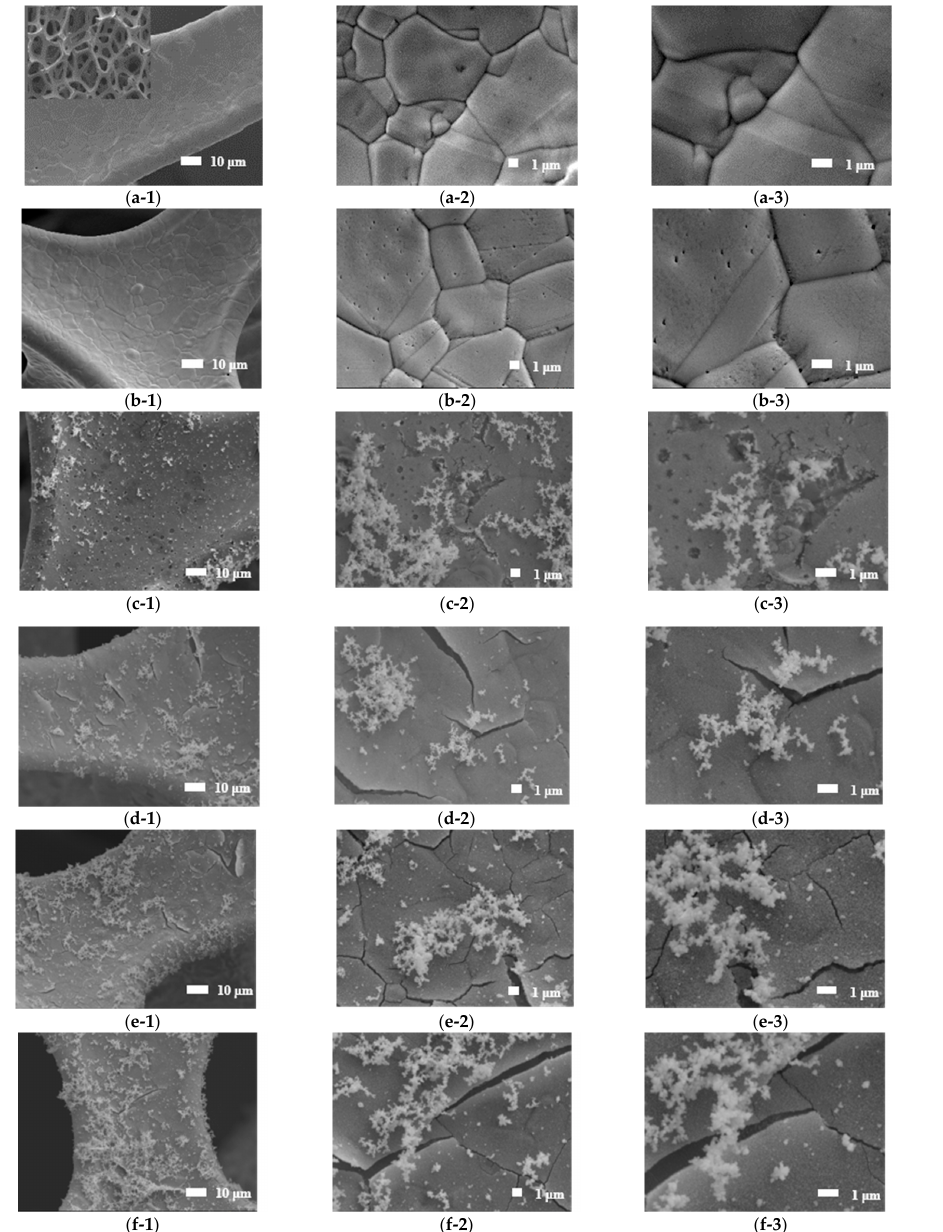
Figure 2. SEM images of pristine NF with ( a-1 ) 1000×, ( a-2 ) 5000×, and ( a-3 ) 10,000× magnification; NF* with ( b-1 ) 1000×, ( b-2 ) 5000×, and ( b-3 ) 10,000× magnification; Ru/NF* with ( c-1 ) 1000×, ( c-2 ) 5000×, and ( c-3 ) 10,000× magnification; Ru/NF*-A with ( d-1 ) 1000×, ( d-2 ) 5000×, and ( d-3 ) 10,000× magnification; Ru/NF*-AH with ( e-1 ) 1000×, ( e-2 ) 5000×, and ( e-3 ) 10,000× magnification; and Ru/NF*-AO with ( f-1 ) 1000×, ( f-2 ) 5000×, and ( f-3 ) 10,000× magnification.